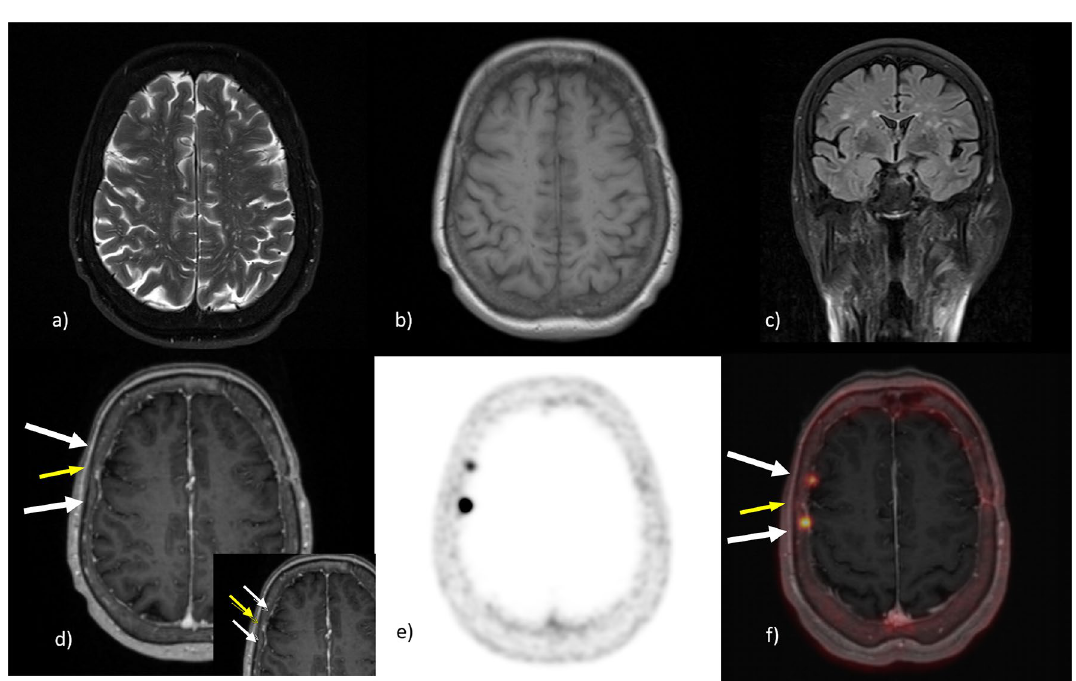
Figure 2. 76 years old female patient with two small frontal ‘en plaque’ meningiomas (white arrows). Very close focus is necessary to distinguish the vessel in the center (yellow arrow) from the two surrounding meningiomas. The meningiomas were non-detected due to their small sizes ( a ) T2 TSE, ( b ) T1 FL2D and ( c ) TIRM. But they could have been detected in MPRage ( d ) the ‘en plaque’ meningiomas are clearly detectable in ( e ) PET und ( f ) PET/MRI